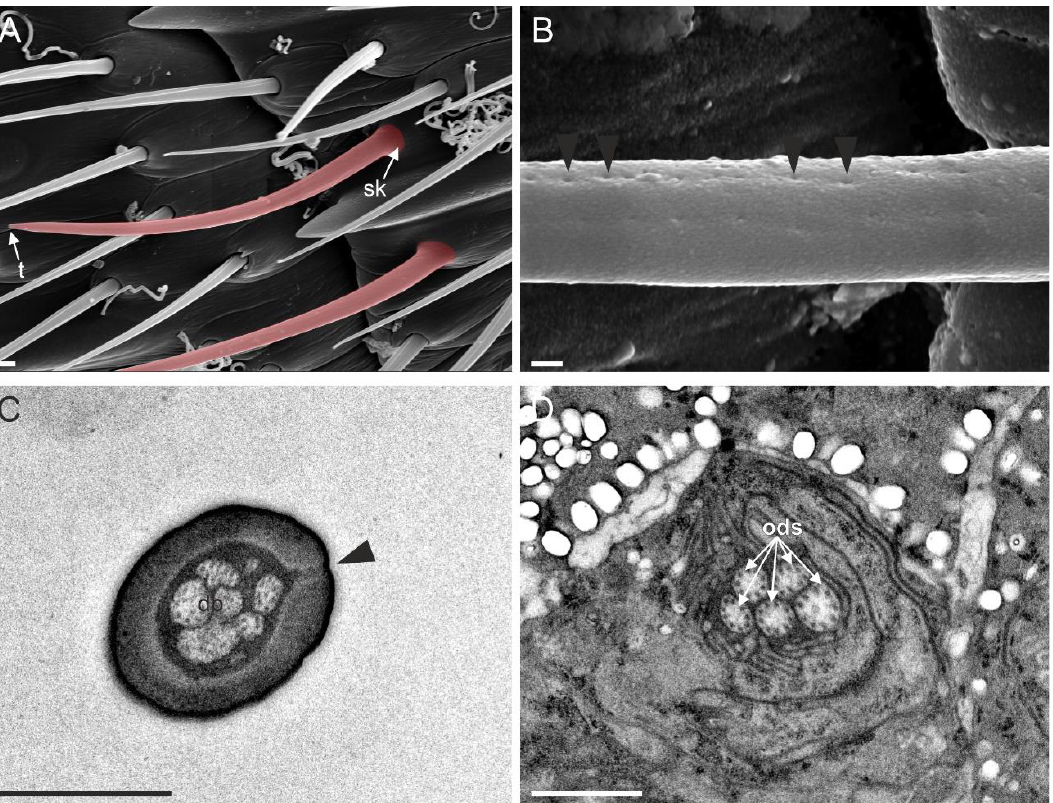
Figure 5. ( A ) SEM picture of the distal area of flagellomere 5 (F5) female antennae in Anagyrus vladimiri , two sensilla trichoidea II (ST II) are visible—highlighted with a red mask. The pointed tip (t) and the inflexible socket (sk) are clearly visible. In ( B ), a series of cuticular pores on the surface of ST II can be observed (black arrowheads). ( C ) TEM picture showing a cross-section of an ST II, the section is taken approximately at the medial region of the sensillum. The lumen is occupied by a series of dendritic branches (db), while a pore is visible, connecting the sensillar lumen with the outside (black arrowhead). ( D ) TEM picture of the same sensillum in ( C ) taken below the sensillum base; five outer dendritic segments (ods) belonging to the sensory neurons innervating the sensillum are visible. Scale bar: ( A , C , D ): 1 µm; ( B ): 0.2 µm.